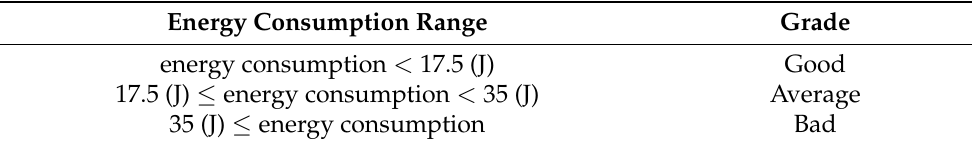
Table 8. Evaluation criteria of energy